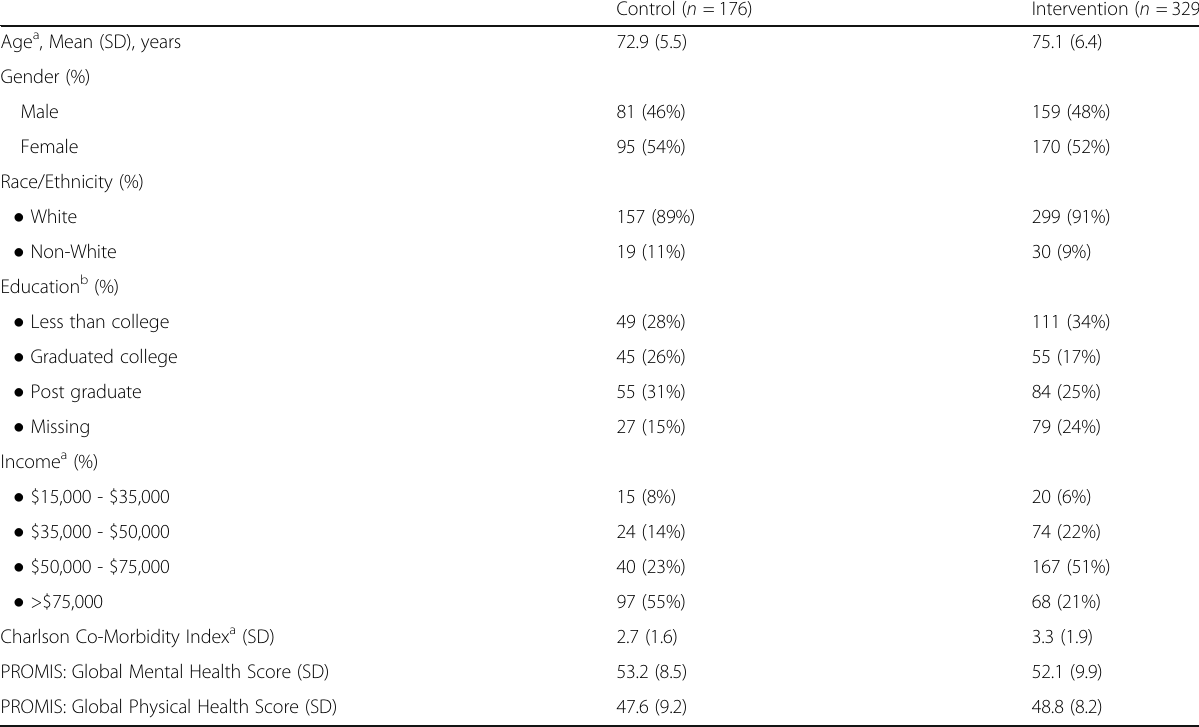
Table 2 Patient demographics ( n =